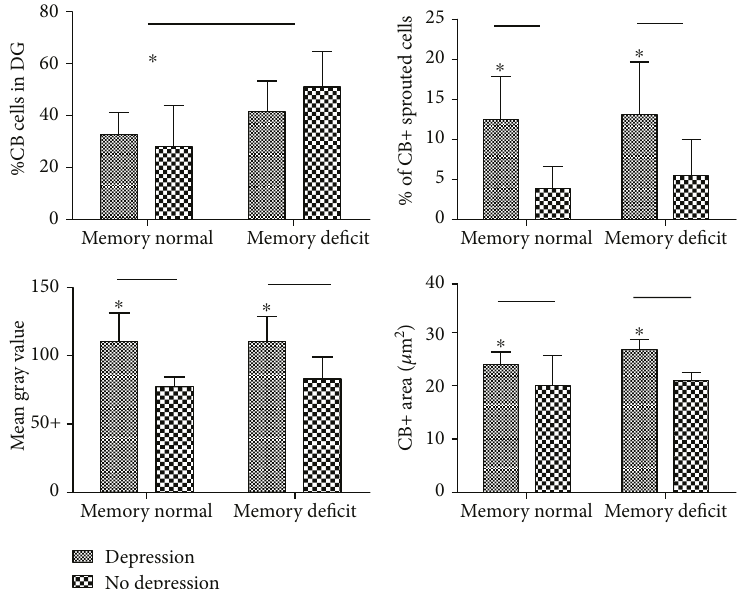
Figure 4: Patients with normal memory showed a lower counting of CB+ cells comparing with TLE patients with memory de fi cits ( ∗ p < 0 05 ). Depression factor was signi fi cantly associated with higher % of CB+ cells with positive dendritic processes (sprouted cells), a higher CB+ optical density (MGV), and a higher CB+ area ( ∗ p < 0 05 ) (two-way ANOVA). No interactions were observed between factors.